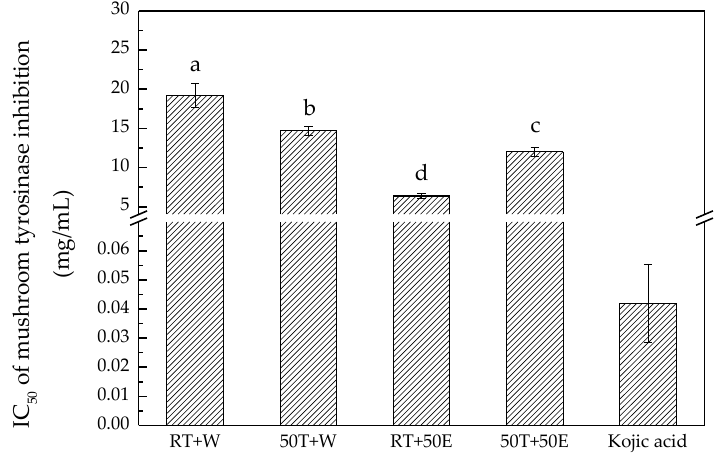
Figure 7. Mushroom tyrosinase inhibition ability of the four extracts and kojic acid. Treatment means with the same letter are not significantly different.